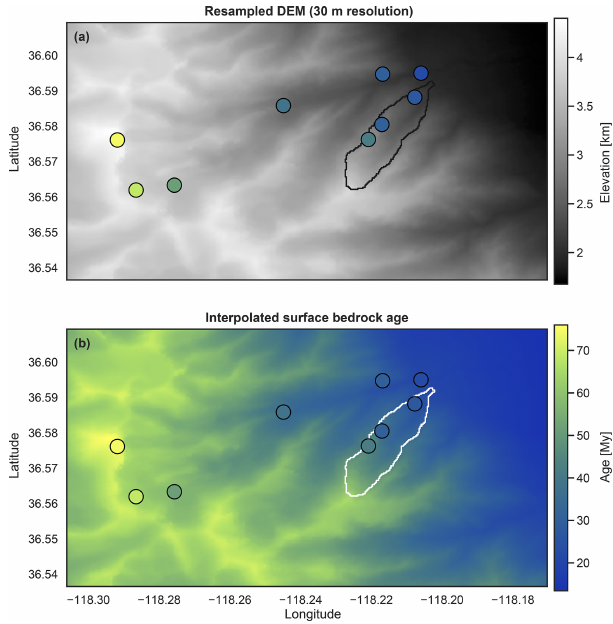
Figure 4. Input bedrock data from Stock et al. (2006). (a) Raster images of the study area’s digital elevation model, resampled to the user-specific cell size, and (b) bedrock surface AHe age interpolated based on the linear regression of age–elevation data. In both plots, point data inform bedrock sample locations and related AHe